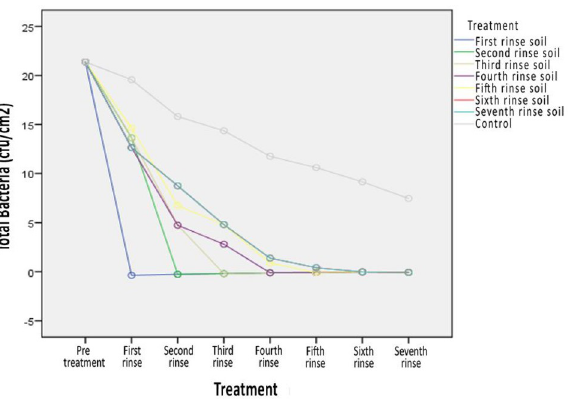
Fig 1. Changes in the decrease in the number of bacteria between the treatment group and the control group.